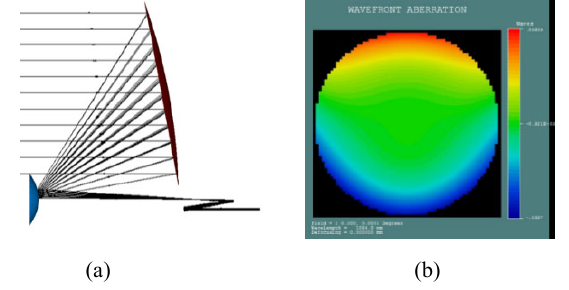
Fig. 5 Optical design of the telescope and its wavefront in the exit pupil: (a) the 4-mirror telescope and (b) the wavefront in the exit pupil.